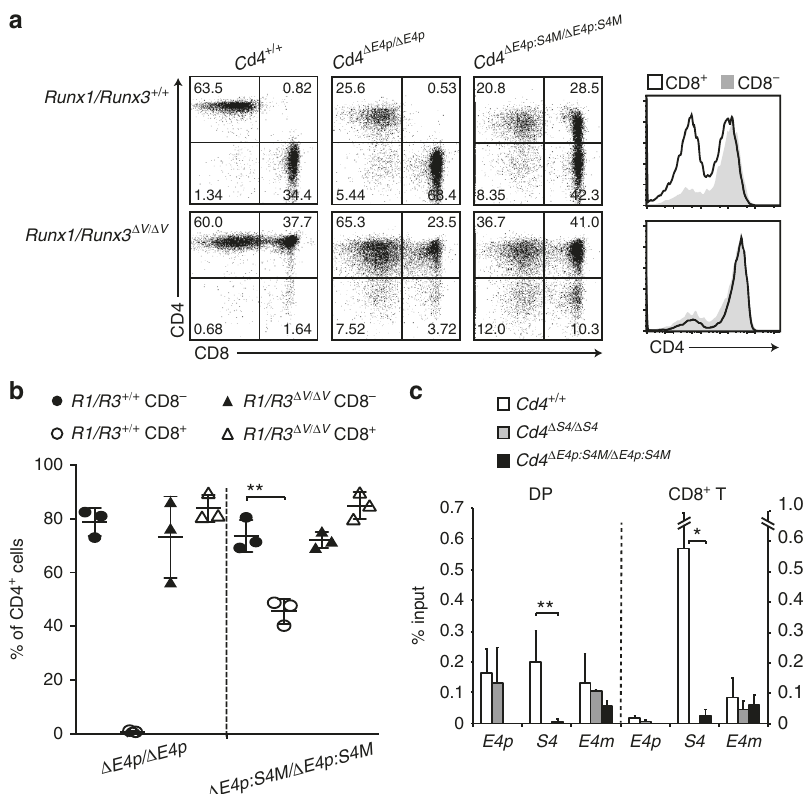
Fig. 6 Involvement of Runx in regulating the helper-lineage dominant activity of E4m . a Dot plots showing CD4 and CD8 expression in lymph node T cells of mice with indicated genotypes. In Runx1/Runx3 Δ V/ Δ V mice, both Runx1 and Runx3 proteins lack the VWRPY motif, which is essential for interaction with TLE/Groucho co-repressors. Right histograms showing CD4 expression level in CD8 − and CD8 + lymph node T cells of Cd4 Δ E4p:S4M/ Δ E4p:S4M mice with (lower) or without (upper) Runx1/Runx3 Δ V/ Δ V mutation. Numbers in quadrants indicate respective cell percentages. One representative result of three independent analyses. b Summary of percentage of CD4 + cells in CD8 − and CD8 + lymph node T cells of Cd4 Δ E4p/ Δ E4p , Cd4 Δ E4p:S4M/ Δ E4p:S4M mice with or without Runx1/Runx3 Δ V/ Δ V mutation. Means± SD. ** p < 0.01 (unpaired student t test, two-sided). c Graph showing summary of three independent ChIP- qPCR for Runx bindings to E4p , S4 , and E4m regions in DP thymocytes (DP) and CD8 + T cells from Cd4 + / + , Cd4 Δ S4/ Δ S4 and Cd4 Δ E4p:S4M/ Δ E4p:S4M mice. Means ± SD. * p < 0.05, ** p < 0.01 (One-way ANOVA and Tukey ’ s multiple comparison